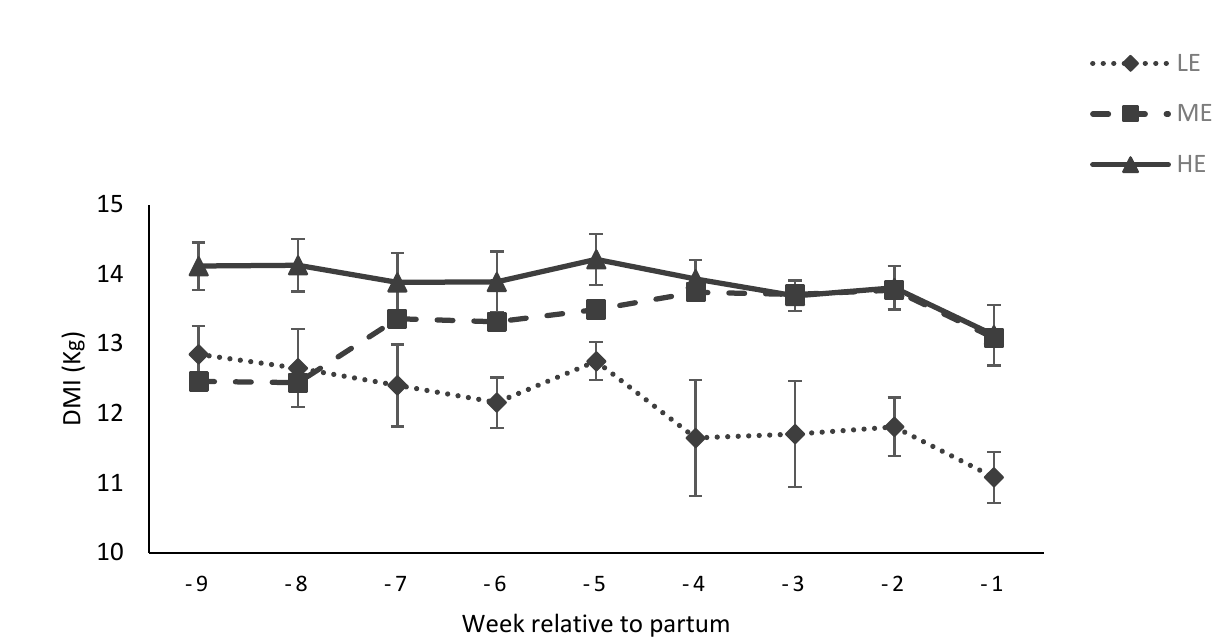
Figure 1. Dry matter intake (DMI; kg/d) of Nili Ravi buffaloes fed a low energy (LE), medium energy (ME) or high energy (HE) level during 9 weeks prepartum. Low, medium, and high energy levels were NE L : 1.30, 1.42, and 1.53 Mcal/kg, respectively, on DM basis in dietary treatments. Values represent LS means ± SEM.